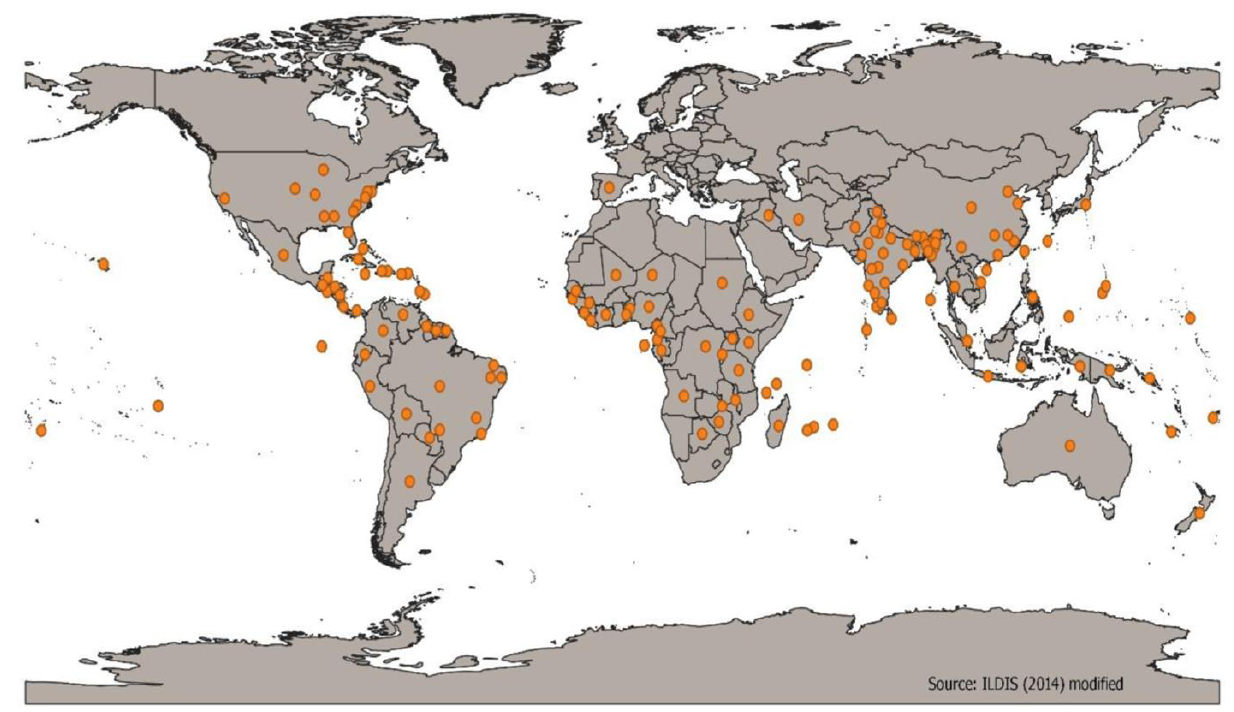
Figure 1. Distribution of lima bean. (Source: [31 – 34]).